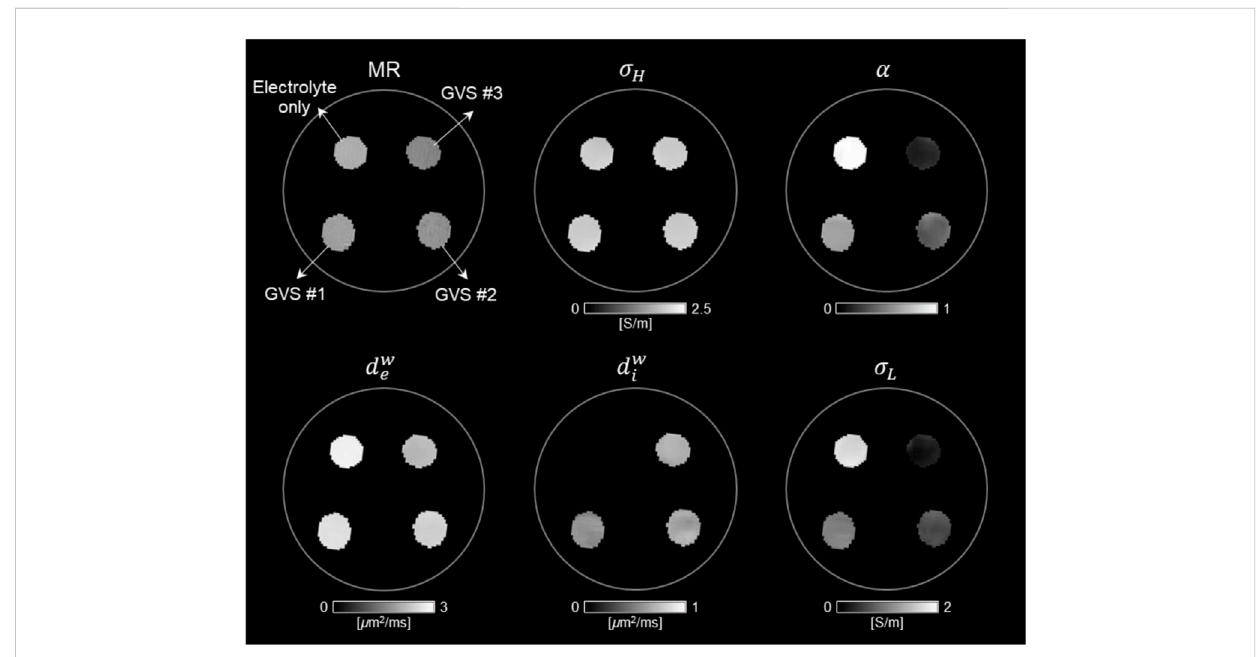
FIGURE 3 Conductivity tensor images of phantom with GVS chambers using a 9.4T MRI. The contrast changes in CTI parameters, such as high-frequency conductivity ( σ H ), extracellular volume fraction ( α ), extracellular diffusion coef fi cient ( d e w ), intracellular diffusion coef fi cient ( d i w ), and low-frequency conductivity ( σ L ), were attributed to the density of